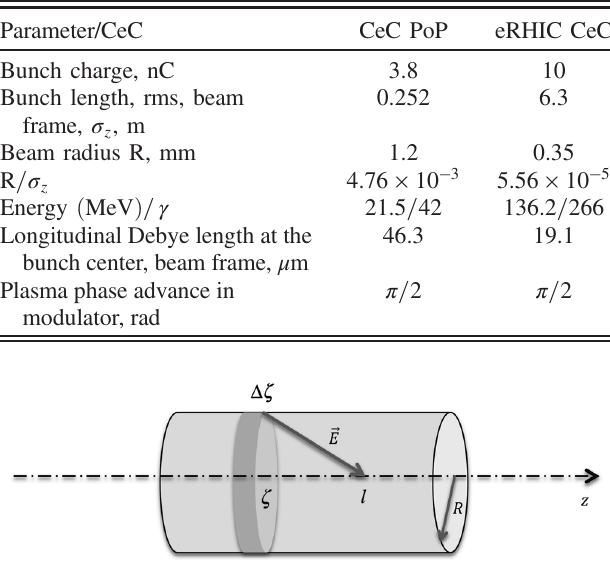
TABLE I. Electron beam parameters for two CeC systems proposed in [7].